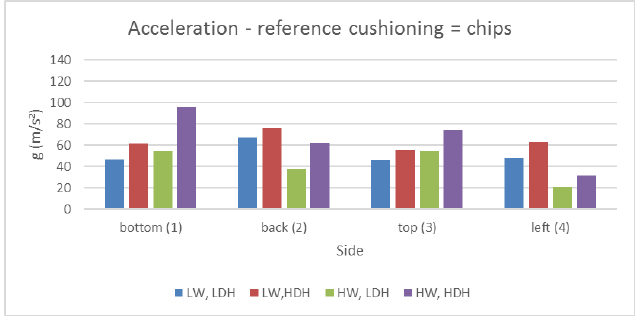
Figure 6: Reference cushioning = chips